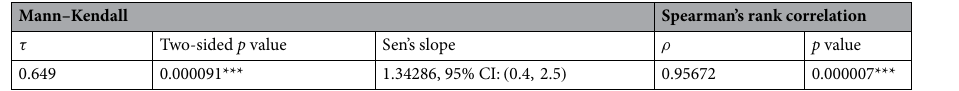
Table 5. β -score. Mann–Kendall test: τ statistic, two-sided p value and Sen’s slope with a confidence interval (CI) of 95% . Spearman’s rank correlation test: rho statistic and one-sided p value for the alternative hypothesis that ρ > 0 .